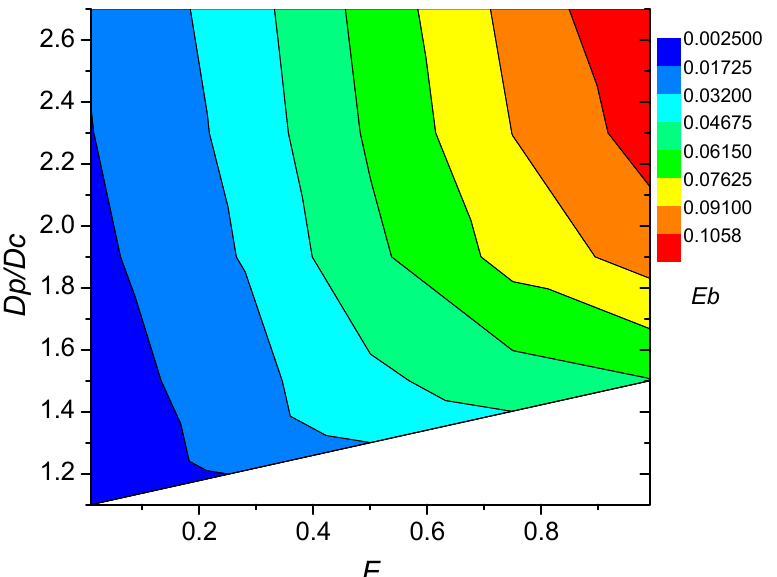
Figure 3. Absorption enhancement of BC reduced by the blocking effect of absorbing coating ( E b ) with an absorbing volume fraction of coating of 0.5 at 550 nm. A BC fractal dimension of 2.8 and log-normal size distribution with r g of 0.075 µ m and σ g of 1.59 are considered.